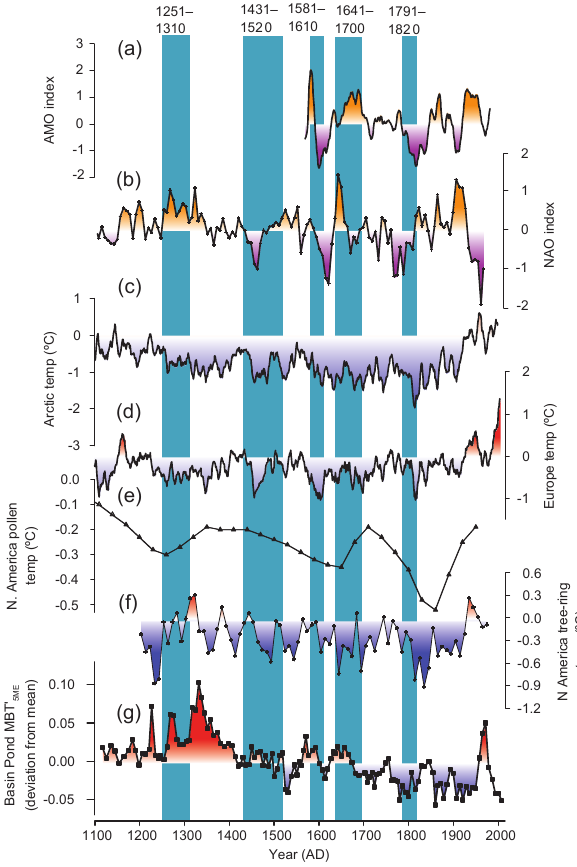
record compared with re- Figure 10. The Basin Pond MBT (cid:48) 5ME gional and global records of temperature change. (a) Tree-ring- based reconstruction of the AMO index (Gray et al., 2004). (b) NAO index reconstruction (Sun et al., 2015). (c–f) Regional tempera- ture stacks based on composite proxy reconstructions for the Arc- tic (c) , Europe (d) , and North America (pollen) (e) ; tree rings (f) . The records have been standardized to have the same mean (0) and standard deviation (1) from AD1190 to 1970 (PAGES2k